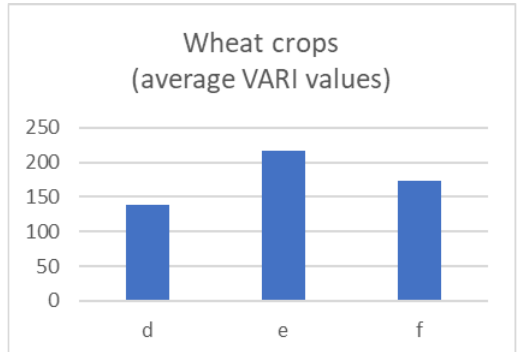
Figure 9 - chart of VARI for rape crops; d- rape germinating, e- rape flowering, f- rape